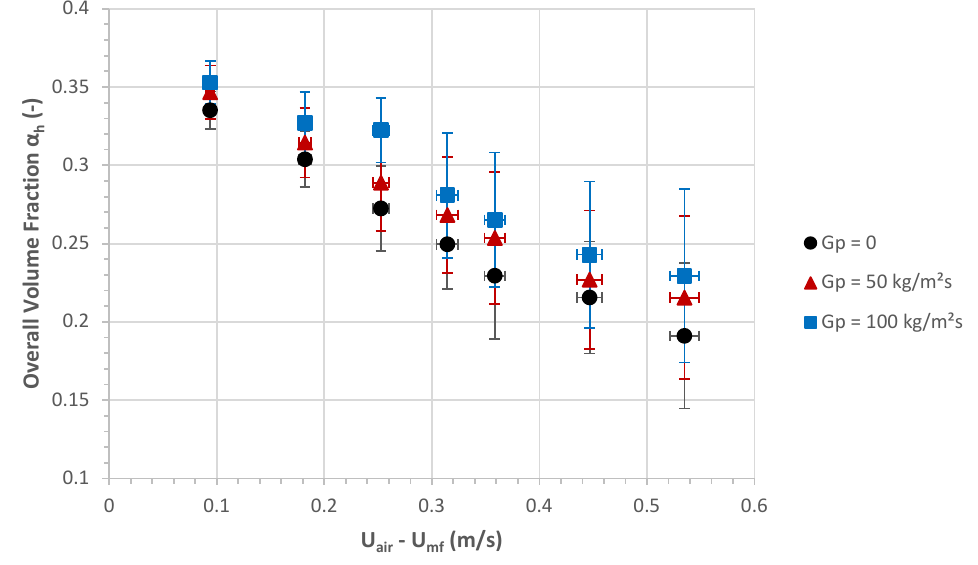
Figure 7. Evolution of the overall solid volume fraction versus the superficial excess air velocity in tube, for three particles mass fluxes.